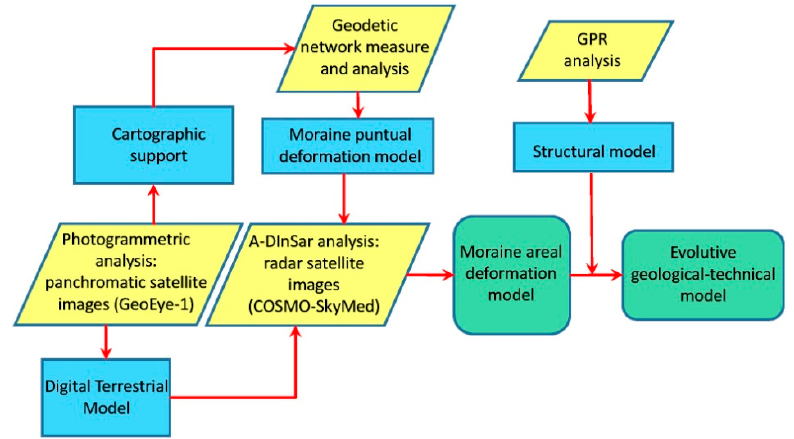
Figure 2. Conceptual sketch of connections between geophysical surveys results and geomorphological characterization of the BCG.